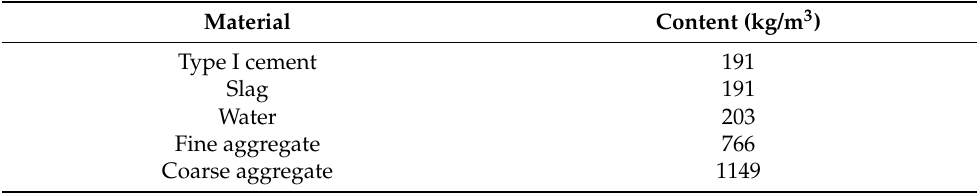
Table 1. Mixture proportion of RC column specimens.